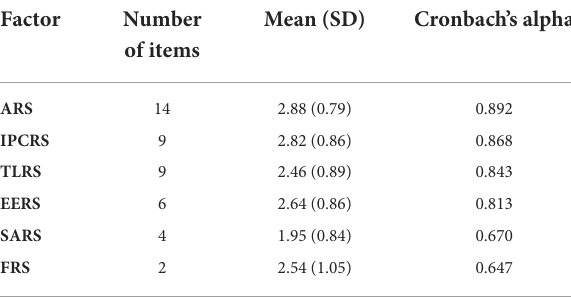
TABLE 3 Questionnaire factors with mean score and reliability estimates (Cronbach’s